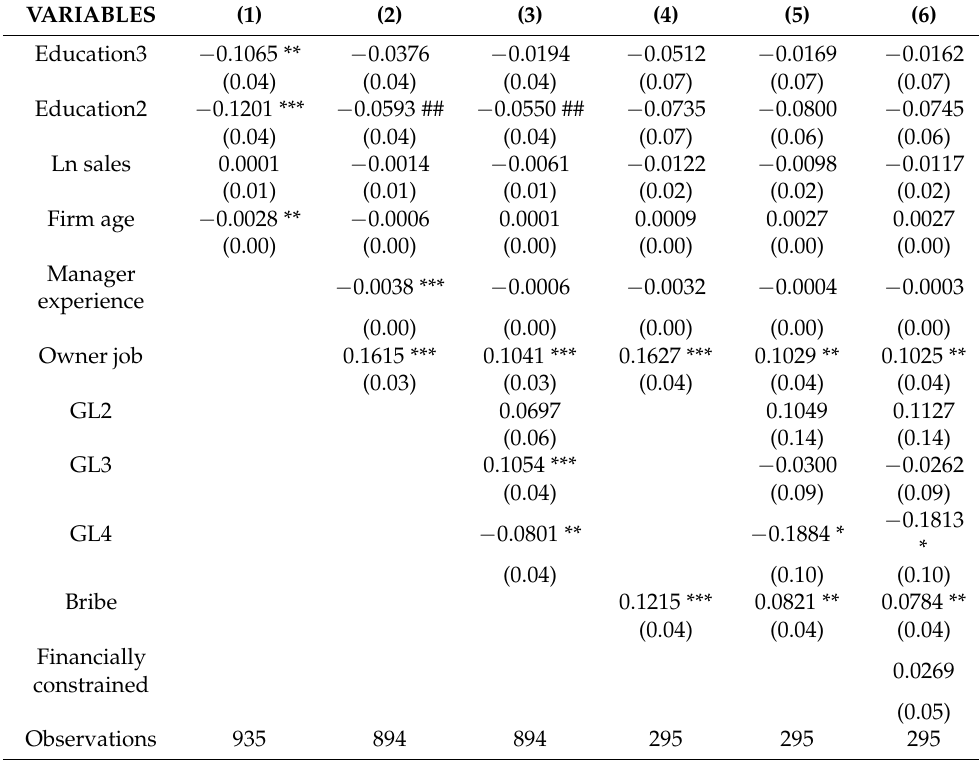
Table 6. Marginal effects of factors affecting female